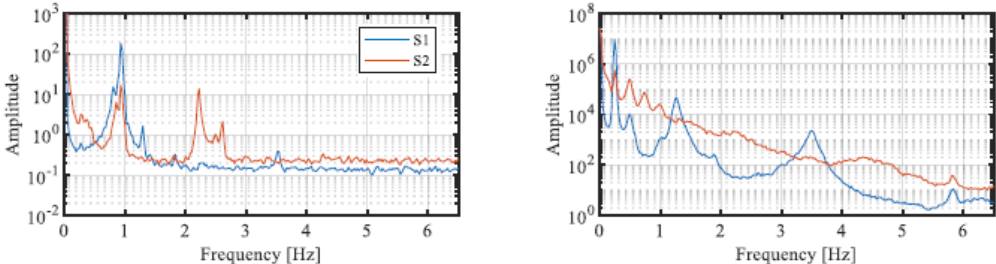
Figure 18. Example of detrended strain time series (static component was removed) and corresponding operation parameters (S1 and S3 bending in the edge-wise direction; S2 and S4 bending in the flap-wise direction) and power